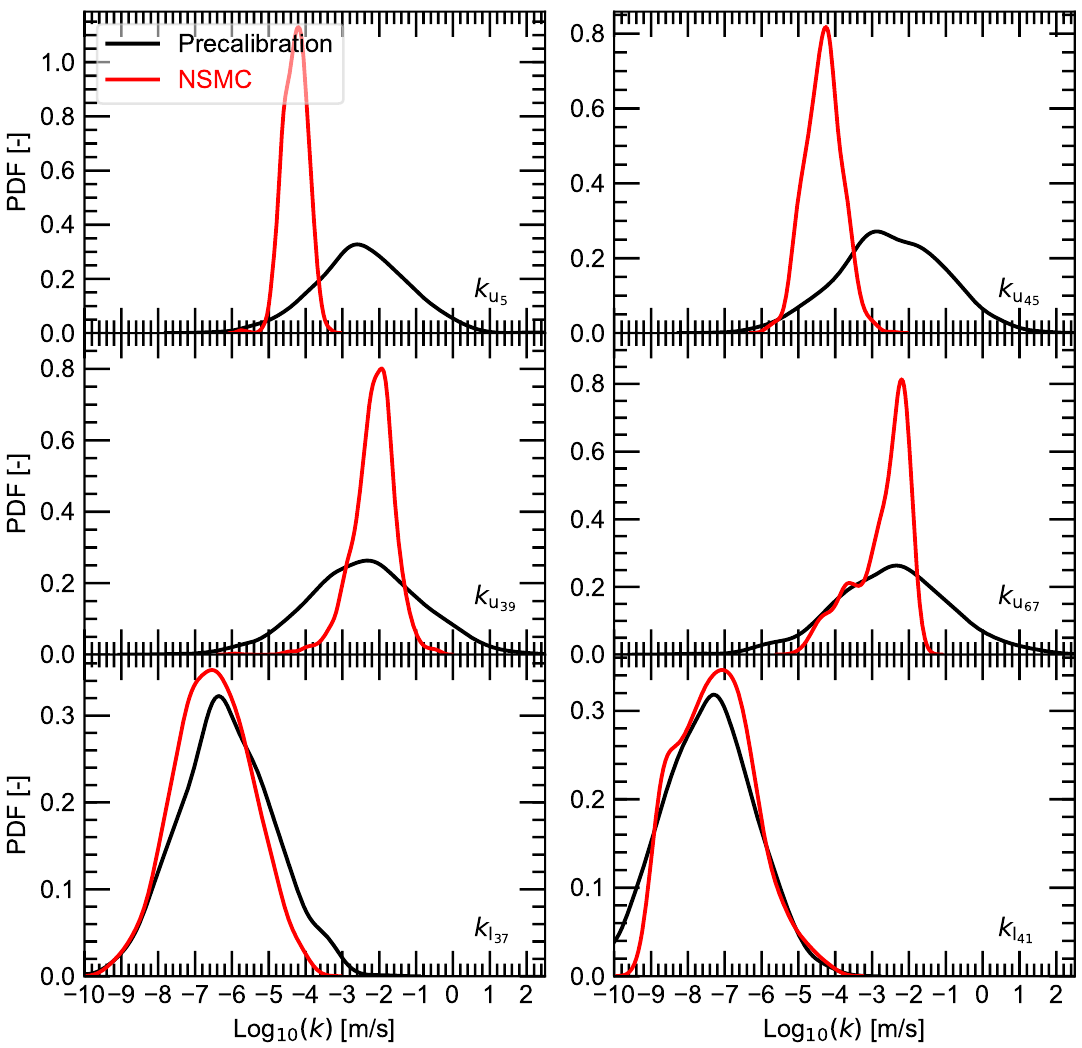
Figure 11. PDFs of highly identifiable parameters k u parameters k u and k u (middle row), and minimally identifiable parameters k l 39 67